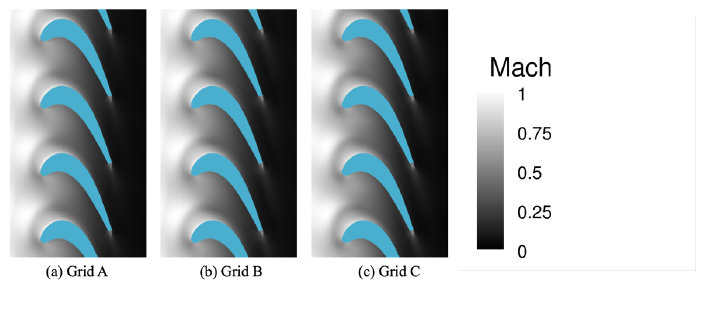
Figure 11. Instantaneous temperature contours near the stator–rotor region at the location of 50% span of the rotor blade for: ( a ) Grid A; ( b ) grid B; and ( c ) Grid C.